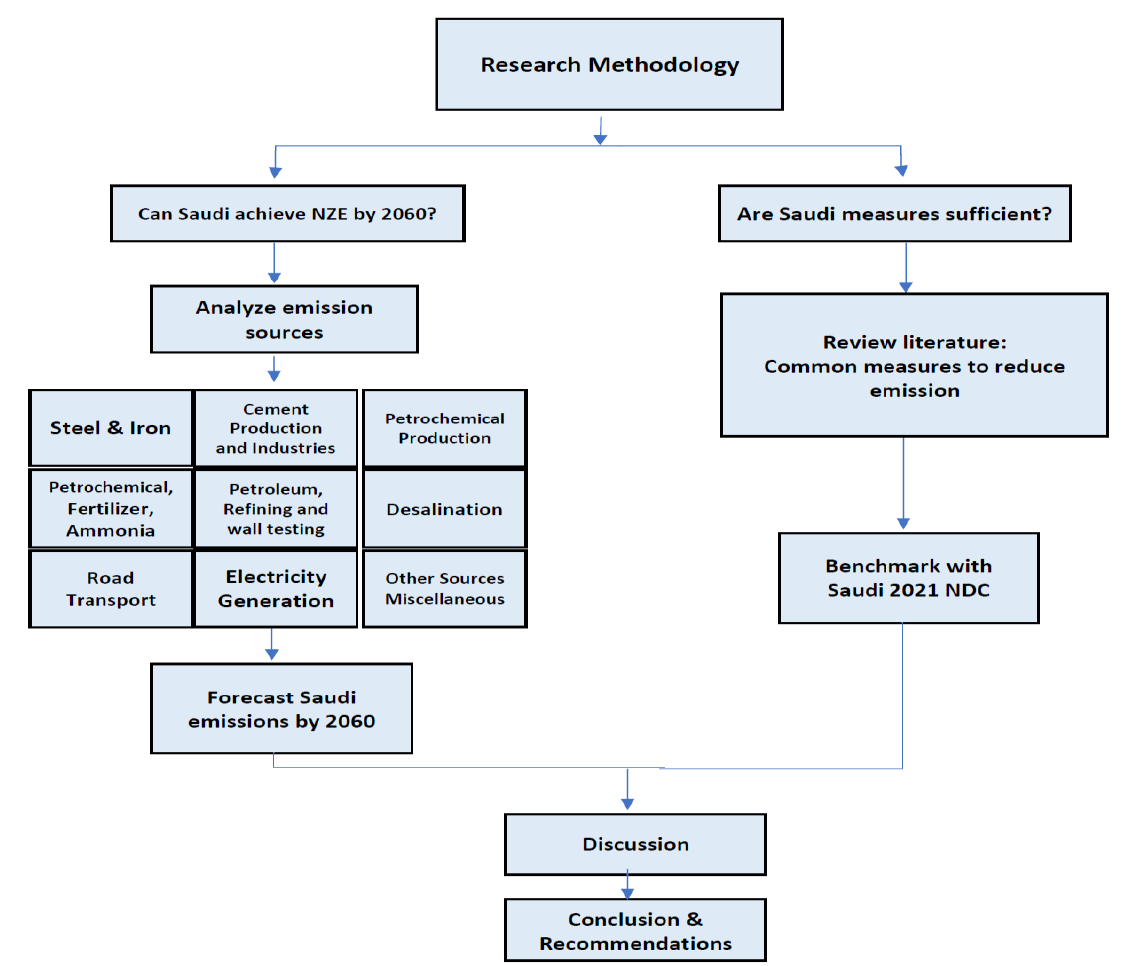
Figure 1. Research Methodology.